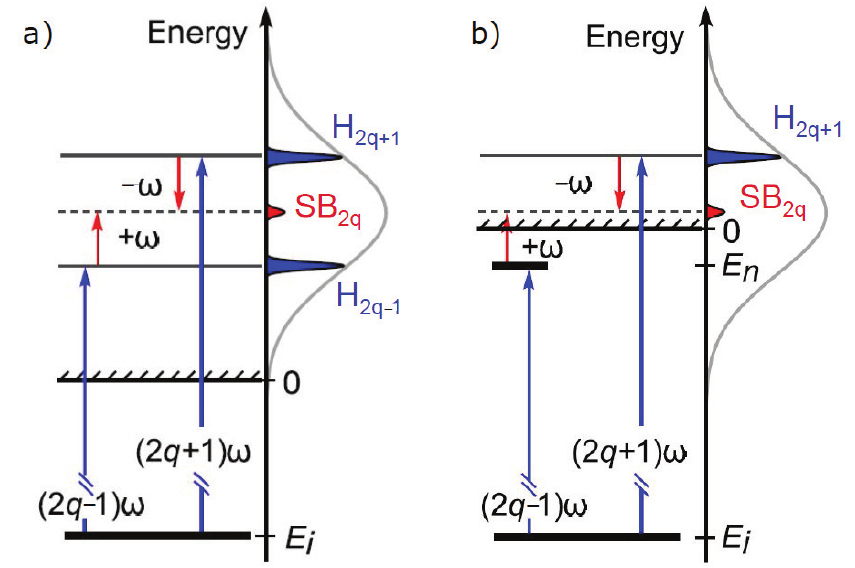
Figure 1. ( a ) Schematic representation of the conventional RABBITT process; ( b ) the same for the uRABBITT